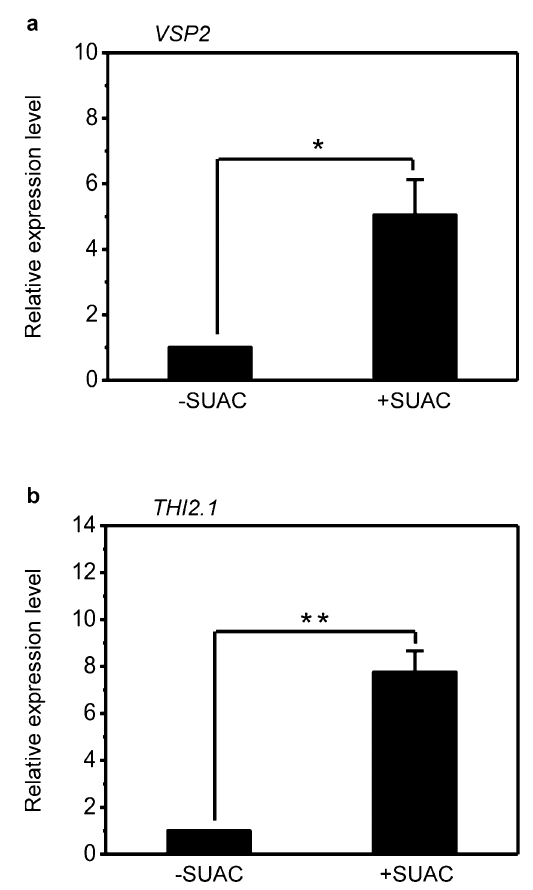
Figure 5. Exogenous SUAC up-regulates the expression of JA-inducible genes VSP2 and THI2.1 . ( a , b ) Relative expression level of JA-inducible genes VSP2 ( a ) and THI2.1 ( b ) in wild-type seedlings that were grown under LD for 3 weeks, and then transferred to SD and treated with ddH 2 0 or 1,280 μg/mL SUAC for 3 days. SUAC, succinylacetone; LD, long day; SD, short day. The expression of genes was analyzed by RT-qPCR, relative expression level was normalized to those of ACTIN2 and the control (without SUAC treatment) was set to 1. Mean ± SE from three biological replicates. Asterisk * and ** represent the significance of differences (two-tailed Student’s t-test) at the levels of P < 0.05 and P < 0.01,